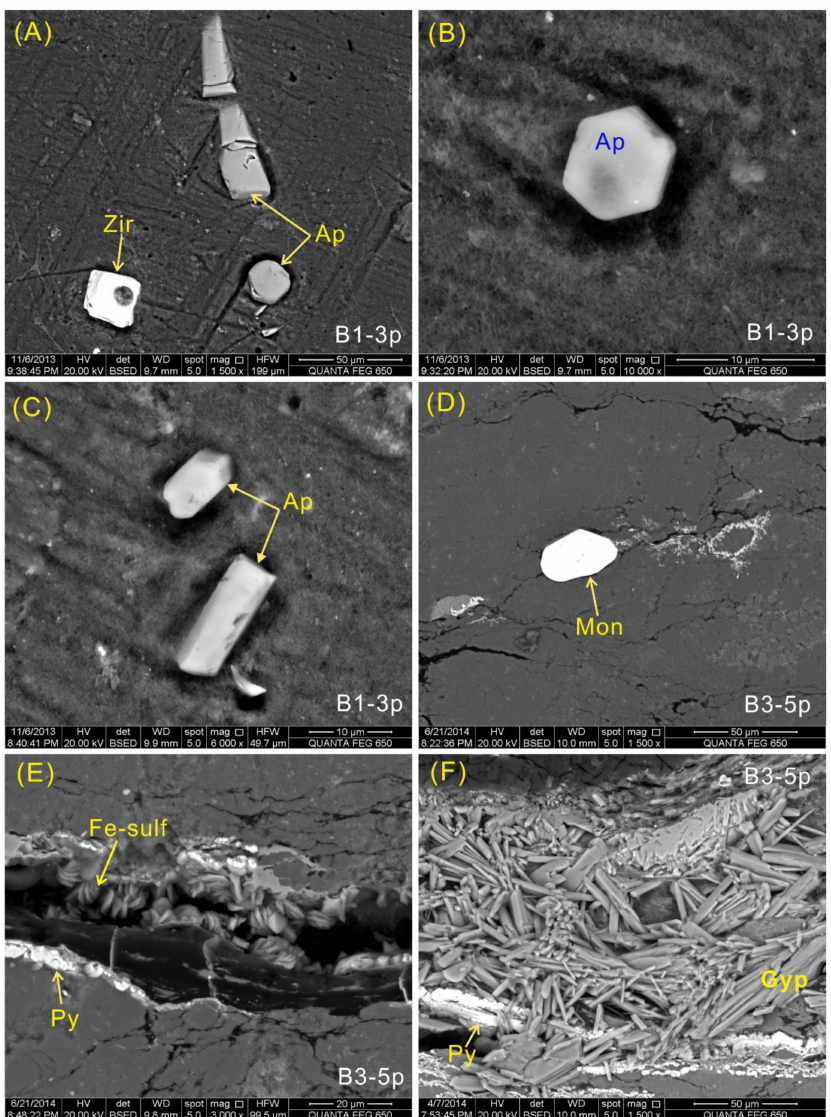
Figure 14. SEM back-scattered electron images of minerals in tonsteins. ( A ) Apatite and zircon in B1-3p. ( B , C ) Apatite crystals disseminated in the kaolinite matrix in B1-3p. ( D ) Monazite in B3-5p. ( E ) Fracture-filling pyrite and iron-sulfate mineral in B3-5p. ( F ) Euhedral gypsum in B3-5p. Zir: zircon. Ap: apatite. Mon: monazite. Py: pyrite. Gyp: